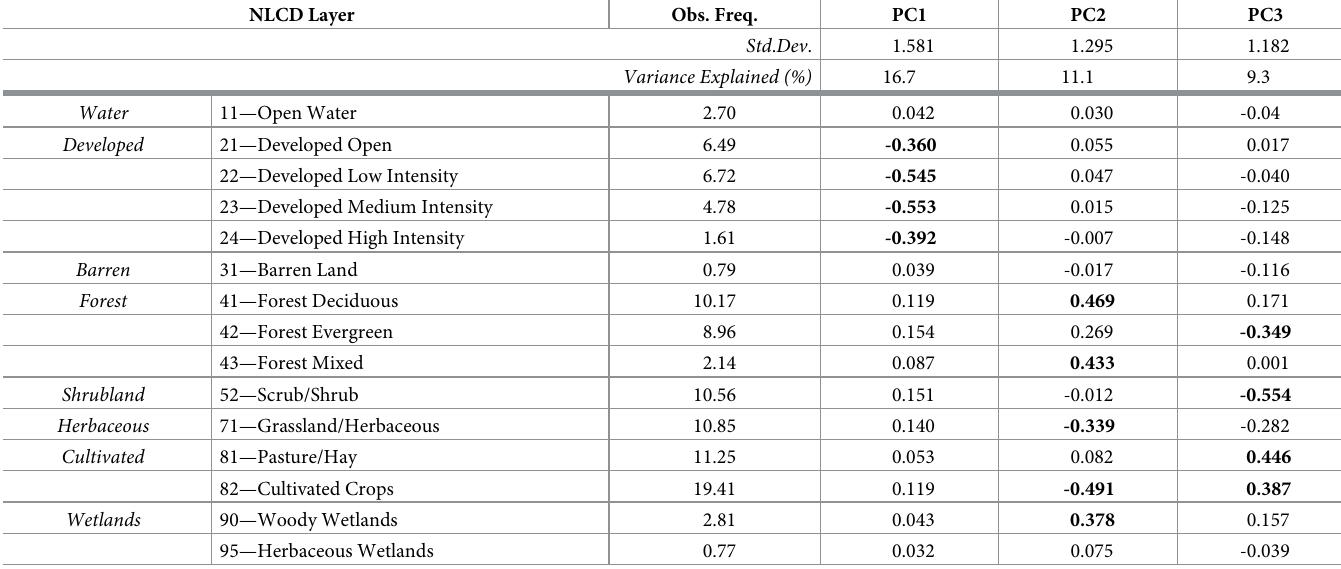
Table 3. Dominant principal component axes.